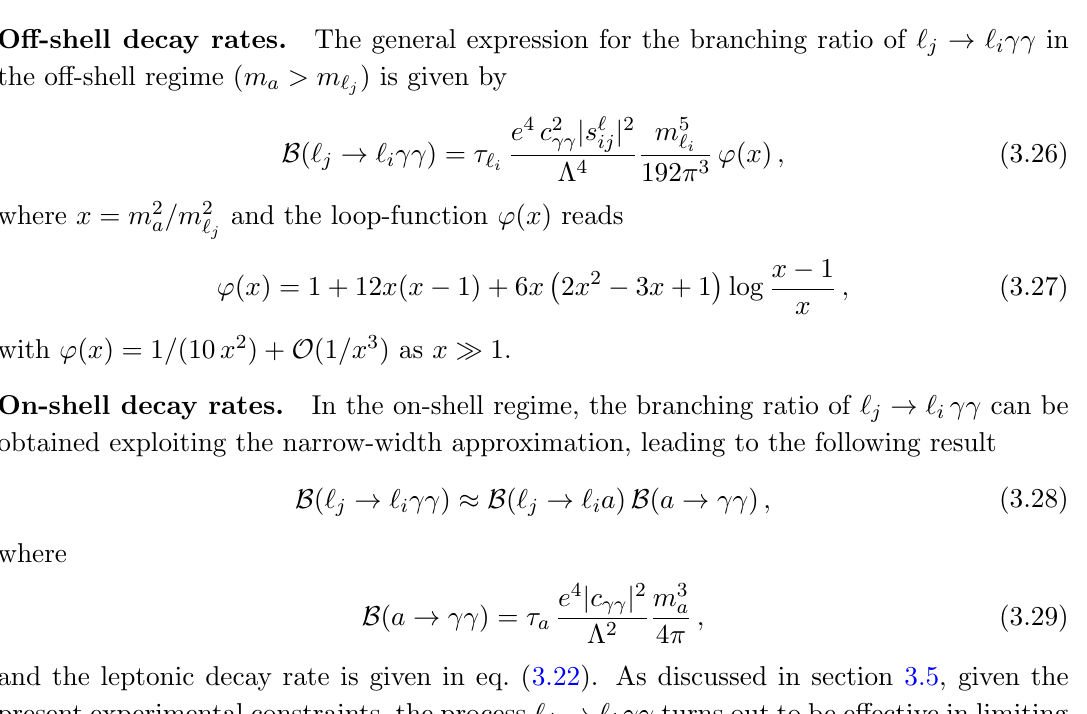
‘ i (cid:13)(cid:13) for light ALPs, i.e. m a . m ‘ !